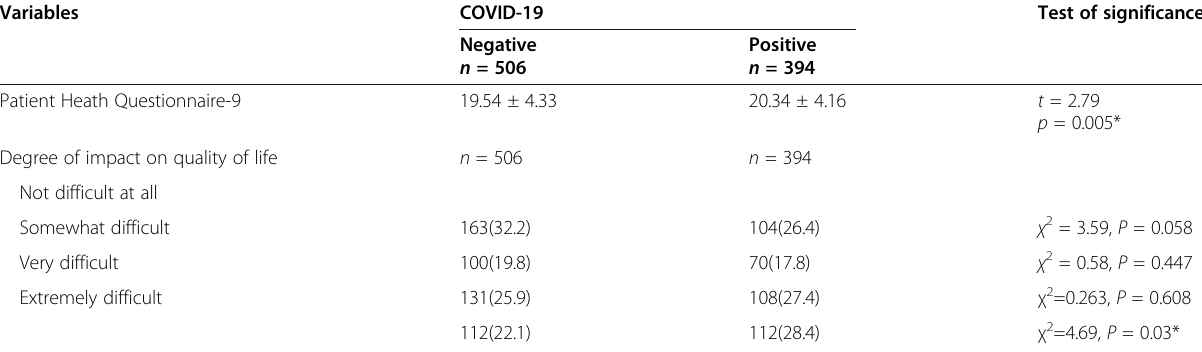
Table 2 Association between socio-demographic, Sheehan Disability Scale, Pandemic Grief Scale, and COVID-19 infection among studied group